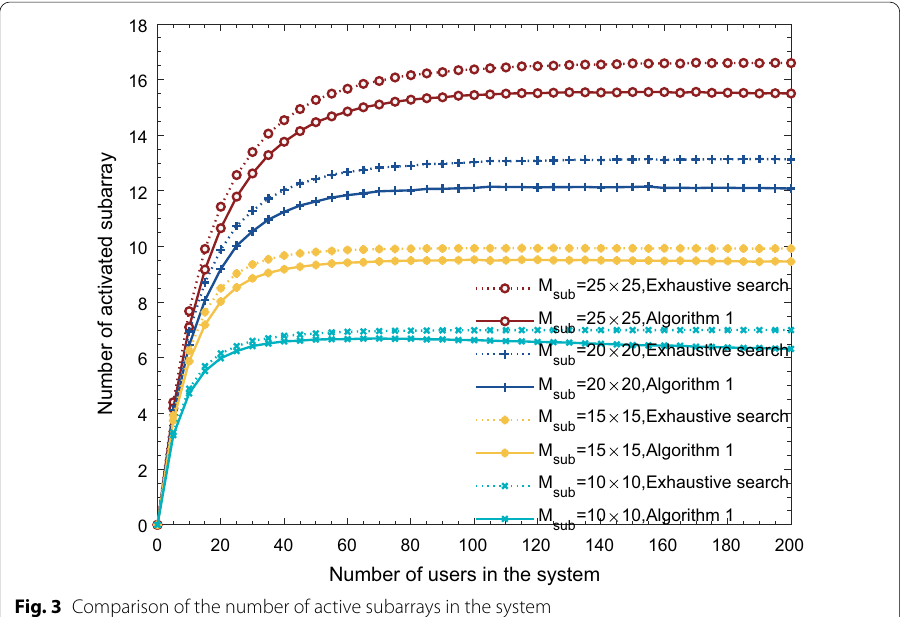
Fig. 3 Comparison of the number of active subarrays in the system